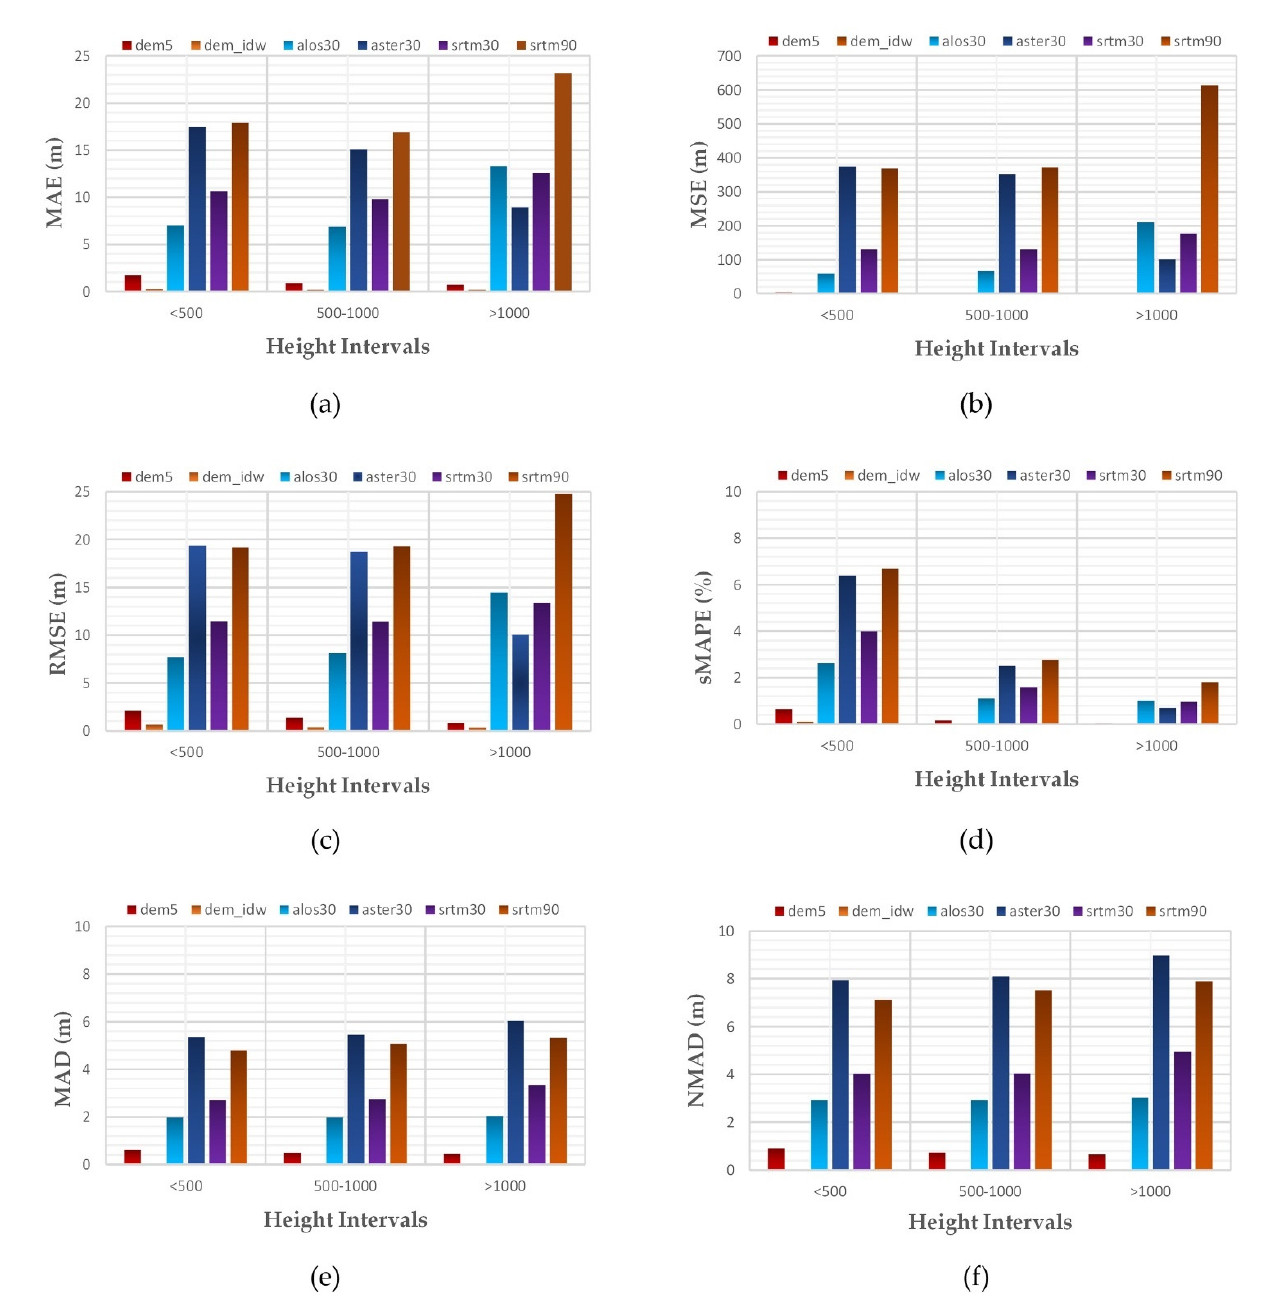
Figure A2. Histograms of the statistical coefficients of the height intervals <500, 500–1000, >1000 for each DEM ( a ) MAE, ( b ) MSE, ( c ) RMSE, ( d ) sMAPE, ( e ) MAD, ( f )